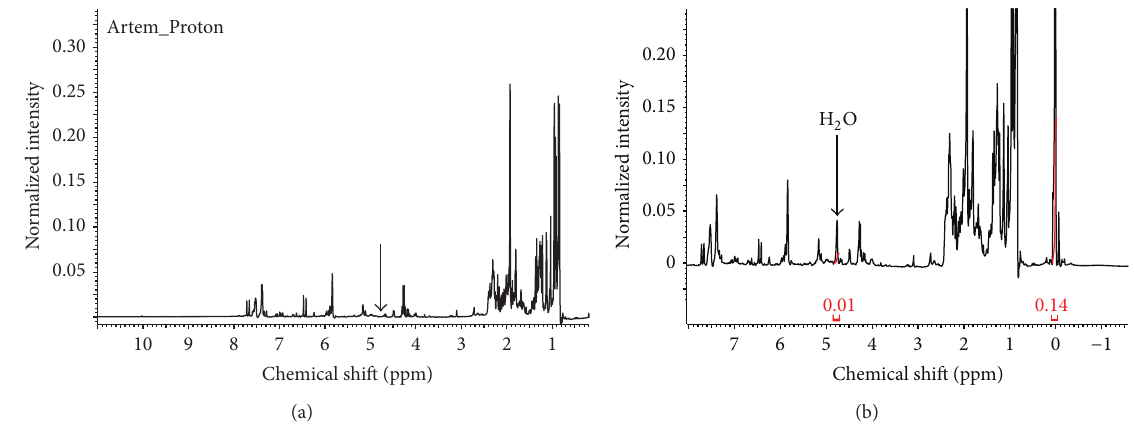
Figure 3: 1 H-NMR spectra of CDCl 3 layer mixed with few drops of D 2 O (a) and the same sample treated with 10mg of A. judaica oil (b). A. judaica oil was able to solubilize water in chloroform layer due its surface activity.